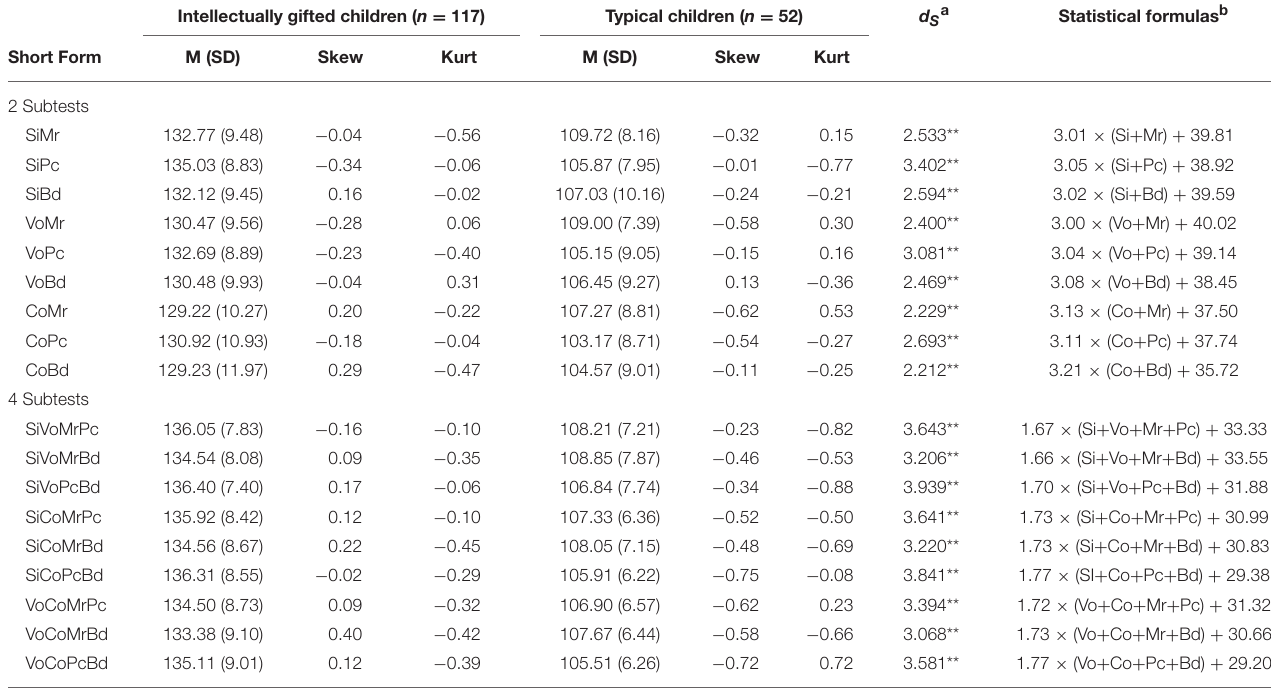
TABLE 2 | Mean (SD) of WISC-IV Short-Form Scores and formulas.